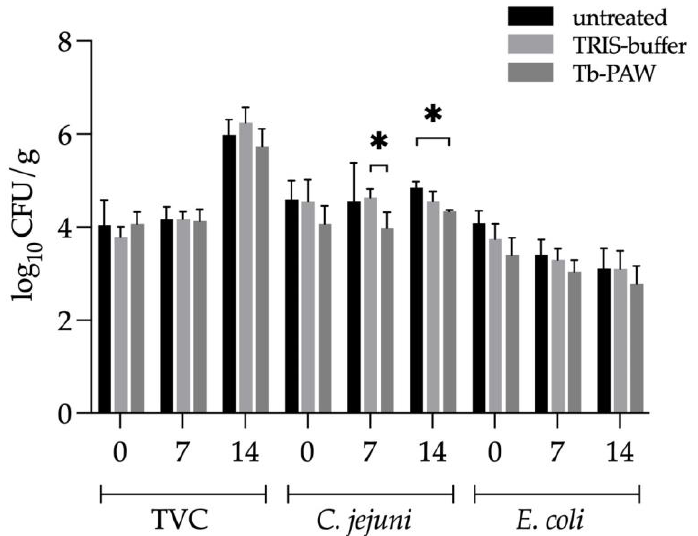
Figure 3. Reduction of the total viable count (TVC), Campylobacter (C.) jejuni and Escherichia (E.) coli on chicken carcasses either with or without Tb-PAW/TRIS-buffer treatment. Untreated and treated breasts (TVC) and thighs ( C. jejuni and E. coli ) with skin were stored in modified atmosphere packages (30% CO 2 , 70% N 2 ) at 4 °C for 14 days. The samples from day 0 were analyzed on the packaging day, the others accordingly without re-treatment on days 7 and 14. Results represent the mean ± standard deviation. Significant differences are defined as * p ≤ 0.05. Tb-PAW = TRIS-buffered plasma-activated water.